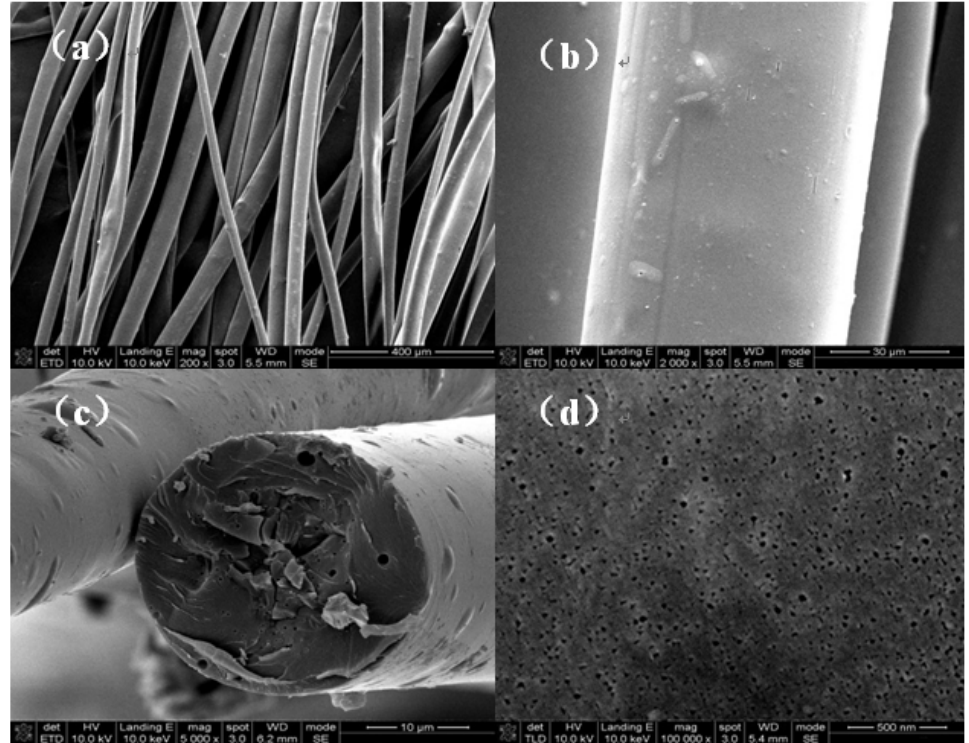
Figure 1. SEM micrographs of activated carbon fibers prepared from bamboo (BACFs):